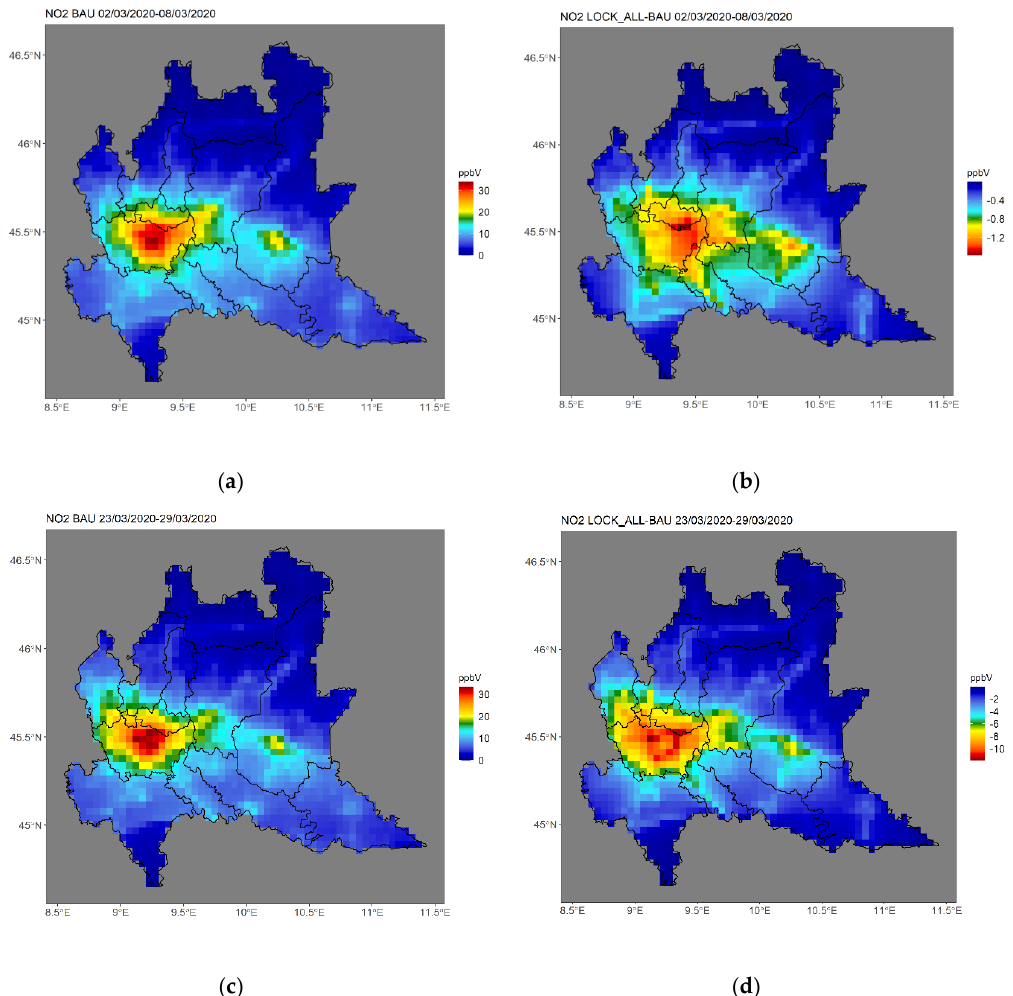
Figure 7. NO 2 weekly mean concentration (ppbV) for the business as usual (BAU) scenario, respectively, for week 2 ( a ) and week 5 ( c ). Absolute difference between LOCK_ALL and BAU scenarios for week 2 ( b ) and week 5 ( d ).